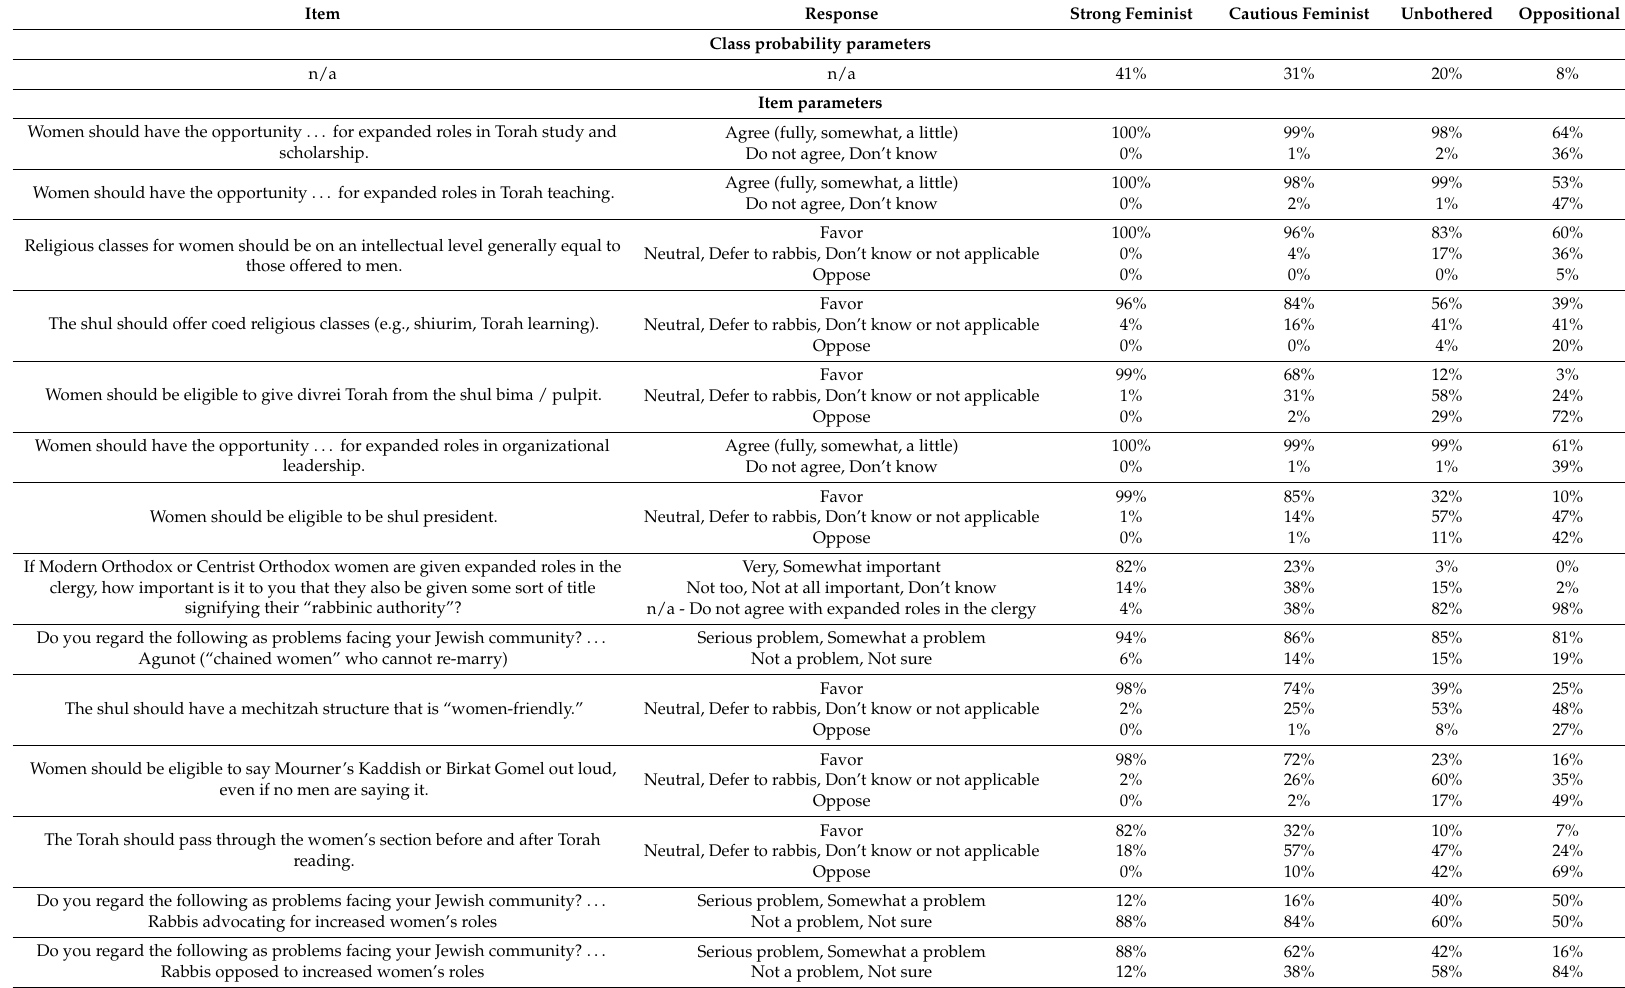
Table 5. Latent class model